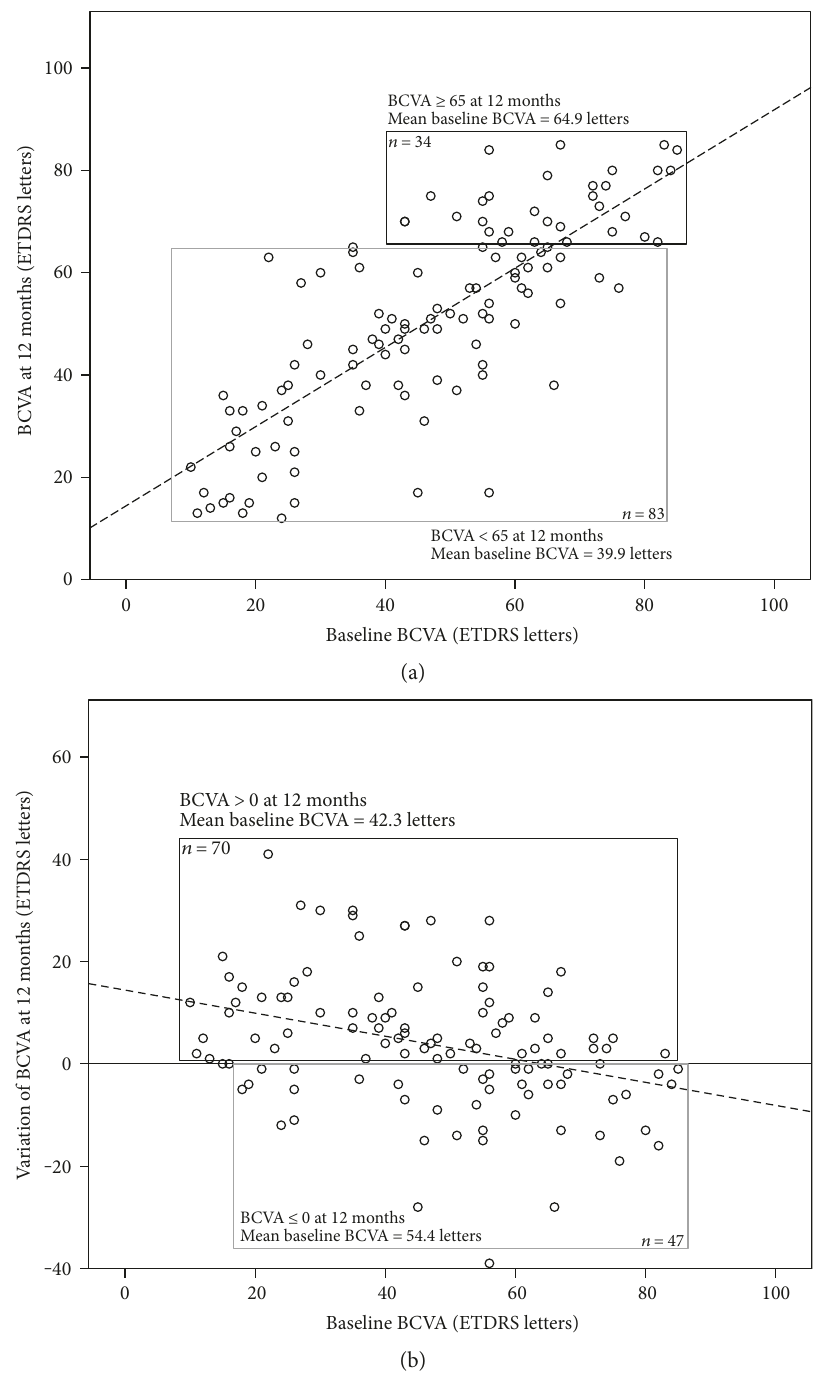
Figure 1: Predictive variables at 12 months. (a) Better BCVA at baseline predicted higher fi nal BCVA score and greater likelihood of achieving 65 ETDRS letters or better, at 12 months. Dashed line = fi tted simple linear regression line. (b) Worse BCVA at baseline predicted higher BCVA variation and greater likelihood of achieving a variation greater than 0 ETDRS letters, at 12 months. Dashed lined = fi tted simple linear regression line. BCVA, best-corrected visual acuity; ETDRS, early treatment diabetic retinopathy